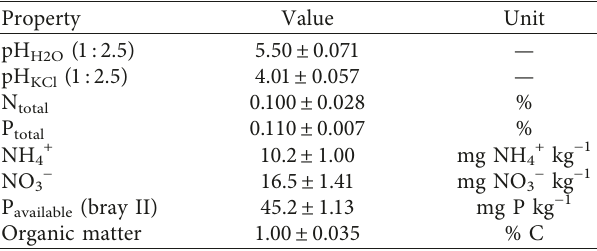
Table 1: Initial soil properties for sesame cultivation. Property